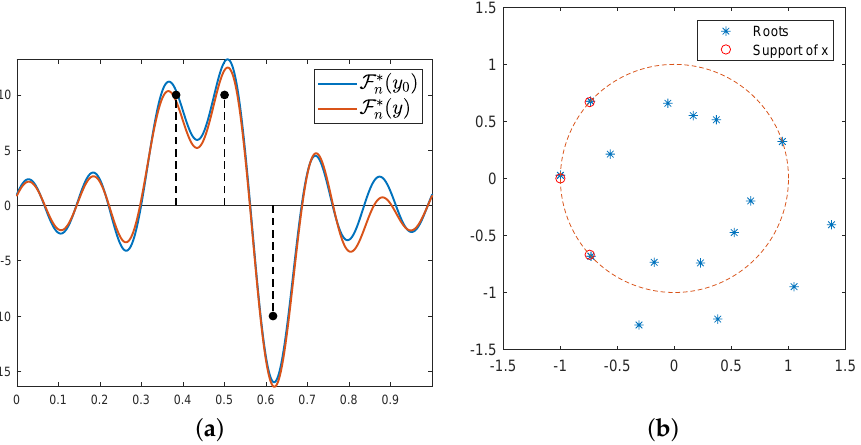
Figure 2. ( a ) Certificates associated with acquisition y and noiseless y 0 , result of three δ -peaks (in black, plotted with 10 times their ground-truth amplitudes) through a Fourier measurement of cut-off frequency f c = 6; ( b ) localisation of the roots of the certificate associated with the dual maximum . All the roots (the three ground-truths and the spurious spike on the right) on the unit circle are interpreted as the support of the δ